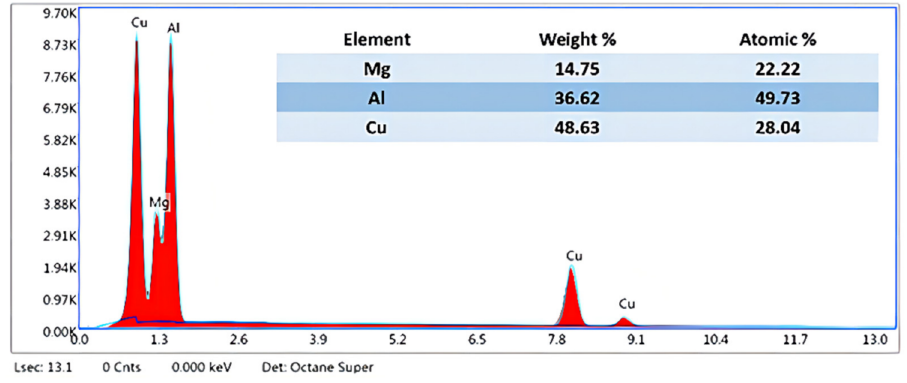
Figure 5. EDS results for the massive